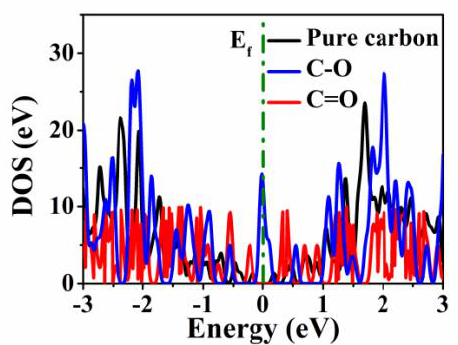
Figure 6. DOS for pure carbon, C=O-doped carbon, and C − O − doped carbon.